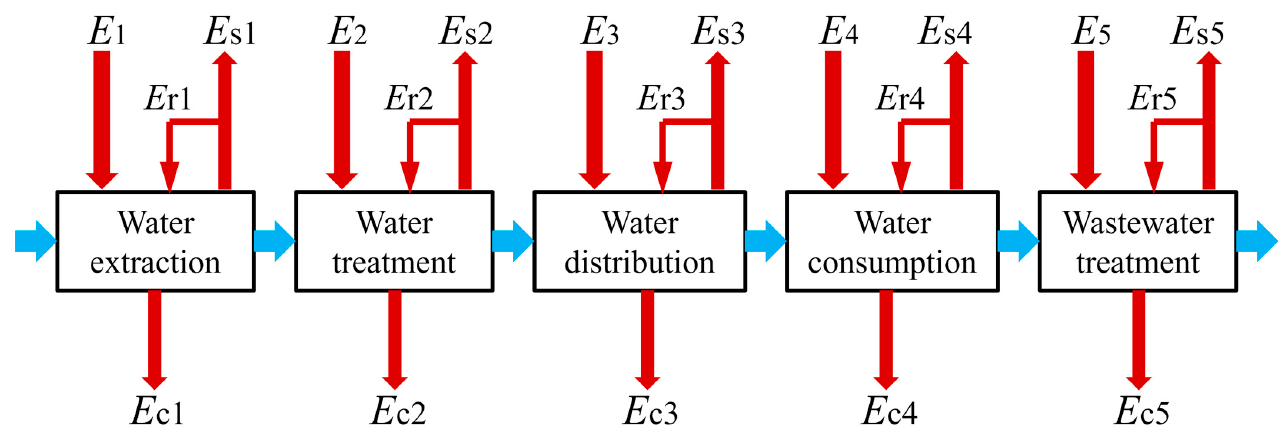
Figure 4. Energy requirement at different stages in the water supply system.